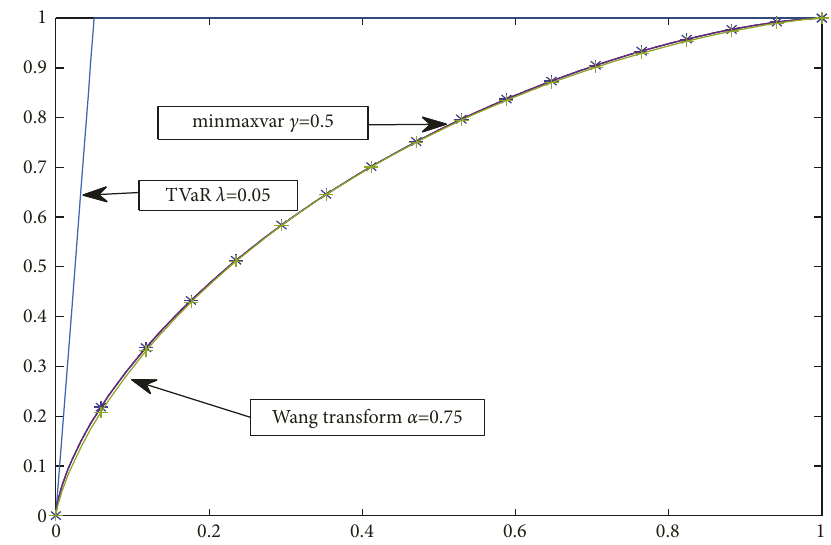
Figure 1: Comparisons of different distortion functions.